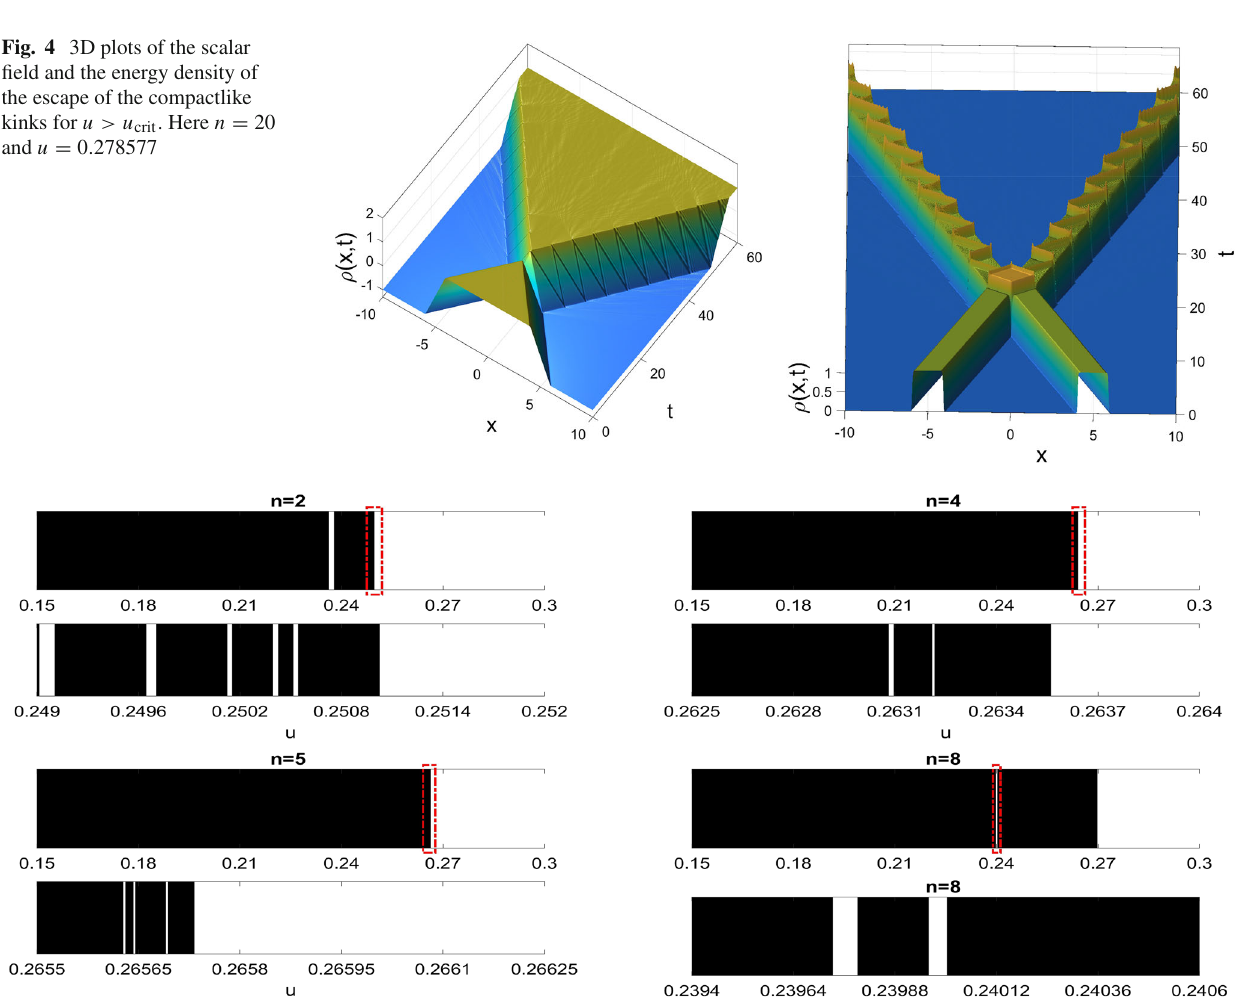
Fig. 5 illustrations of the fractal structure by zooming in some of the boundaries of the windows of escape for the collision of compactlike kinks with distinct values of